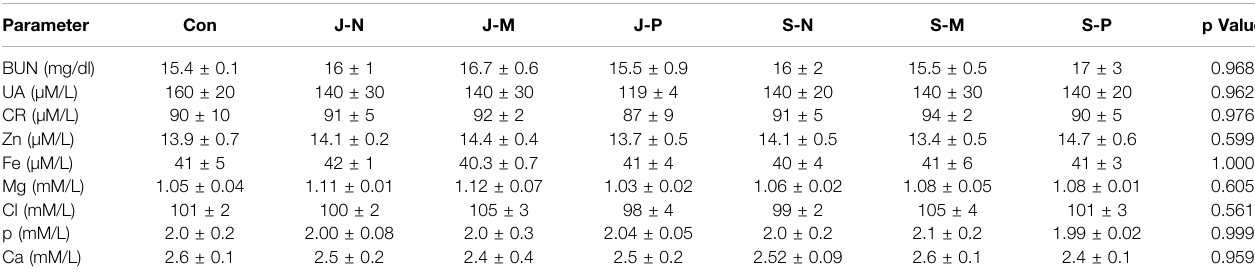
TABLE 4 | Kidney function and electrolytes after different PAL treatments.